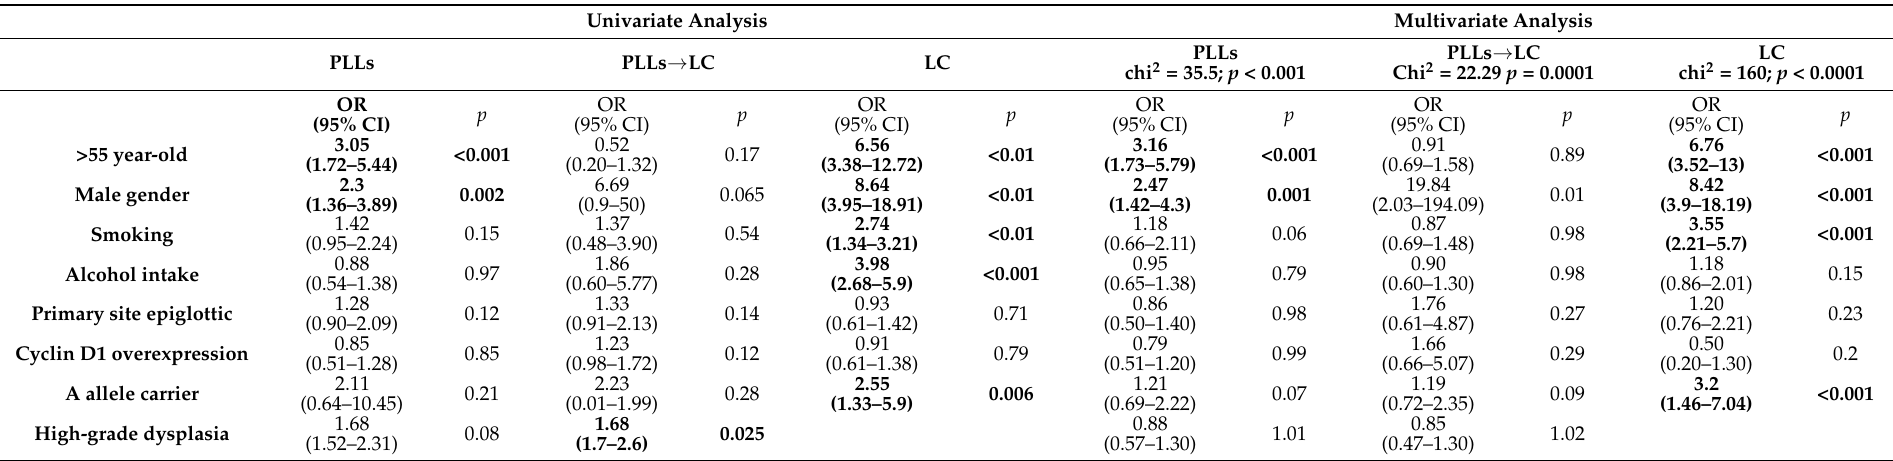
Table 4. Risk factors for premalignant laryngeal lesions (PLLs), laryngeal cancer (LC) and PLLs with progression to LC (PLL → LC), statistically significant data are in bold ( p <